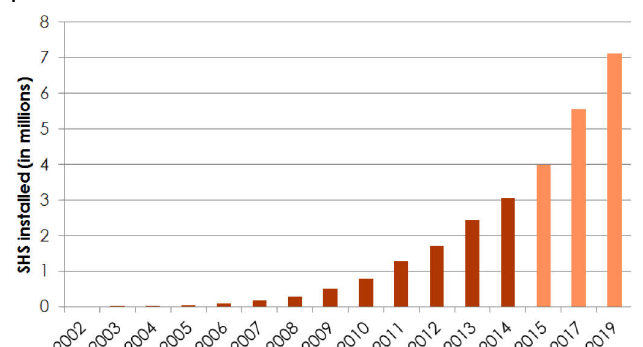
Figure 8: IDCOL SHS Program and Growth